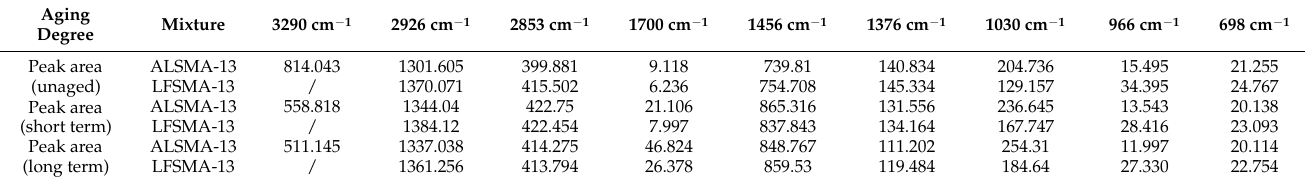
Table 5. Characteristic peak areas of asphalt material extracted from